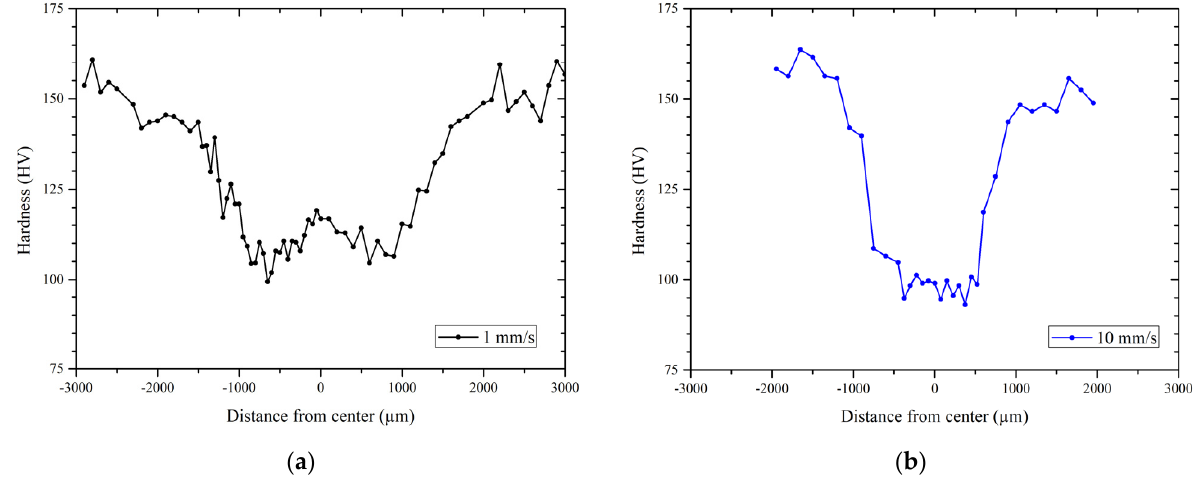
Figure 9. Hardness profiles beneath the laser irradiated surfaces with laser speeds of ( a ) 1 mm/s; ( b ) 10 mm/s.